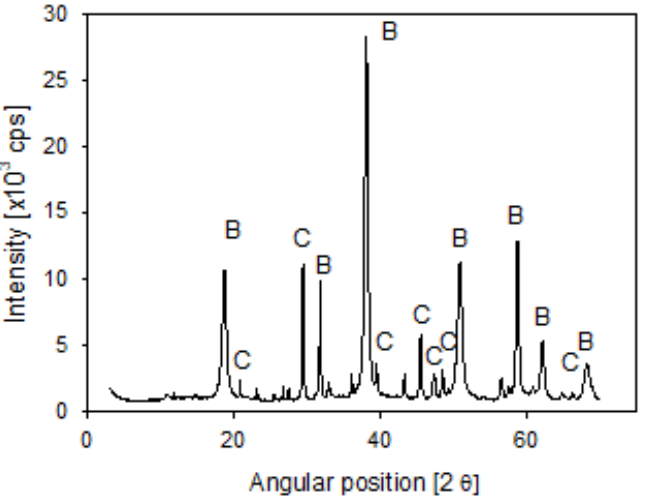
Figure 3. X-ray diffraction of seawater precipitates, showing brucite (B) and calcite (C). The magnesium concentration in the treated seawater was then measured by inductively coupled plasma mass spectrometry (ICP-MS) and confirmed to be 10 mg/L, representing 97% removal.